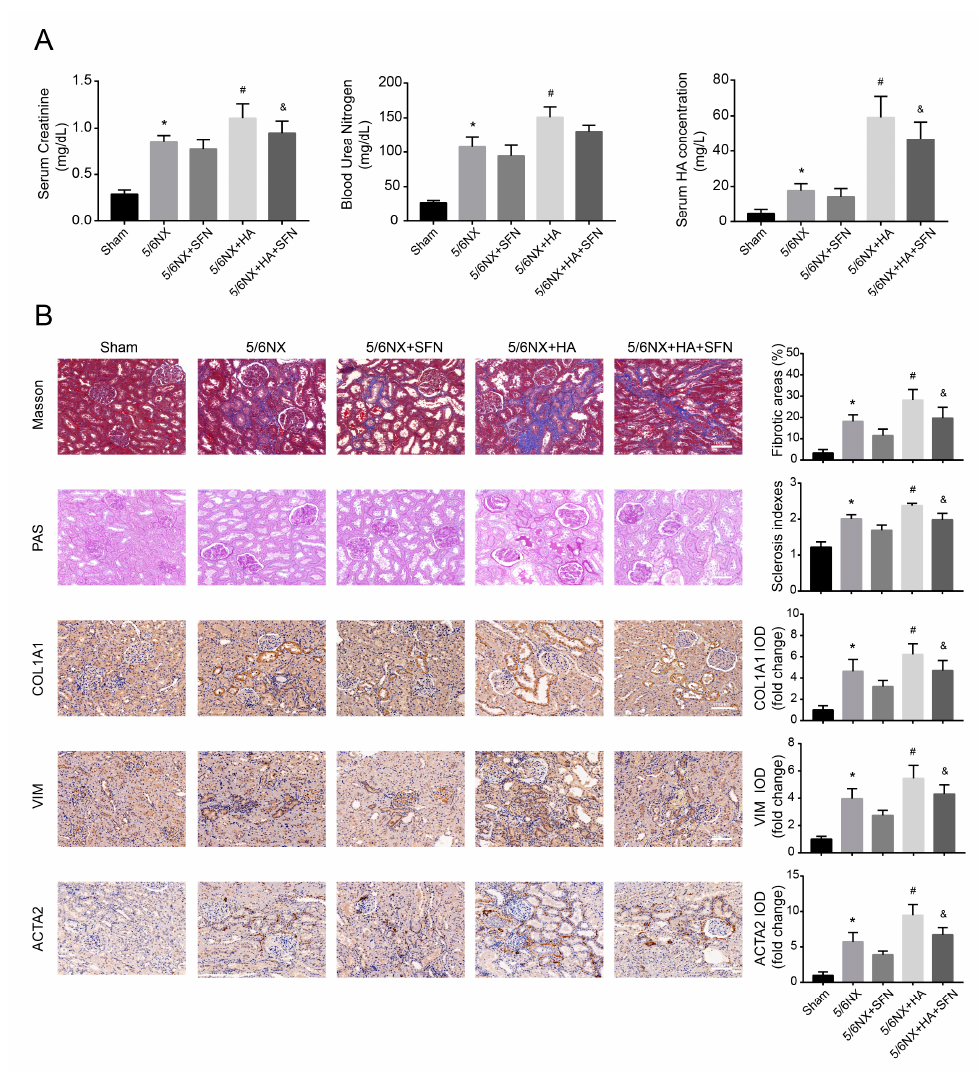
Figure 7. Effects of HA on dysfunction and fibrosis in rat kidneys. ( A ) Serum creatinine (SCr), blood urea nitrogen (BUN), and serum HA concentrations in rats. ( B ) Fibrotic areas, sclerosis indexes, and immunohistochemistry data for collagen-I (COL1A1), vimentin (VIM), and alpha-smooth muscle actin (ACTA2) in kidney samples. Positive areas were quantified (right) by densitometry. Bar = 100 µ m. Data are presented as the means ± standard deviation ( n = 9 per group). * p < 0.05 vs. sham group; # p < 0.05 vs. 5 / 6th nephrectomy (5 / 6NX) group; and & p < 0.05 vs. 5 / 6NX + HA